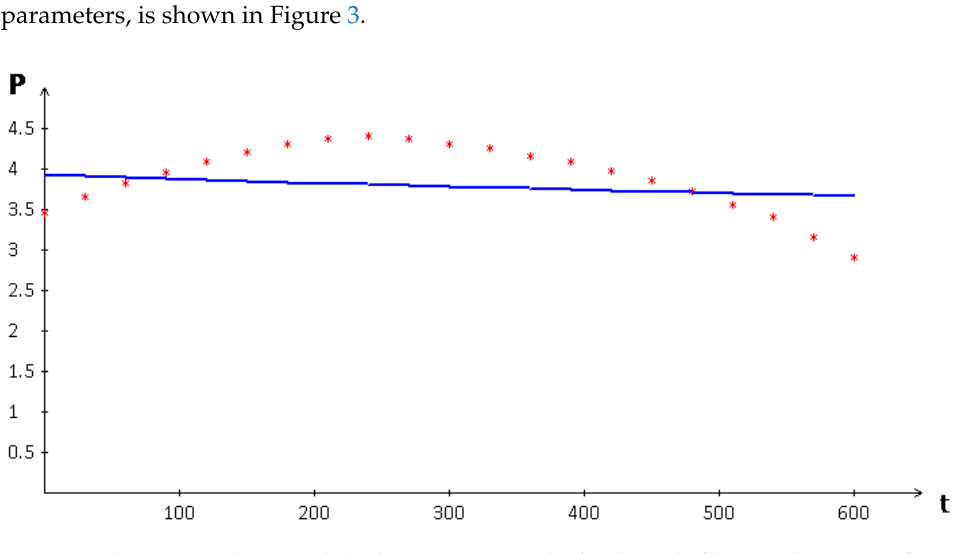
Figure 3. Ultimate tensile strength (ordinate in Newtons) of polyamide fibers with TiO 2 as a function of irradiation time (abscissa in minutes). The asterisks on the graph are the model data, and the curved line is the results of the approximation of the model data by the Equation (14), the coefficients of which are obtained by the Monte Carlo